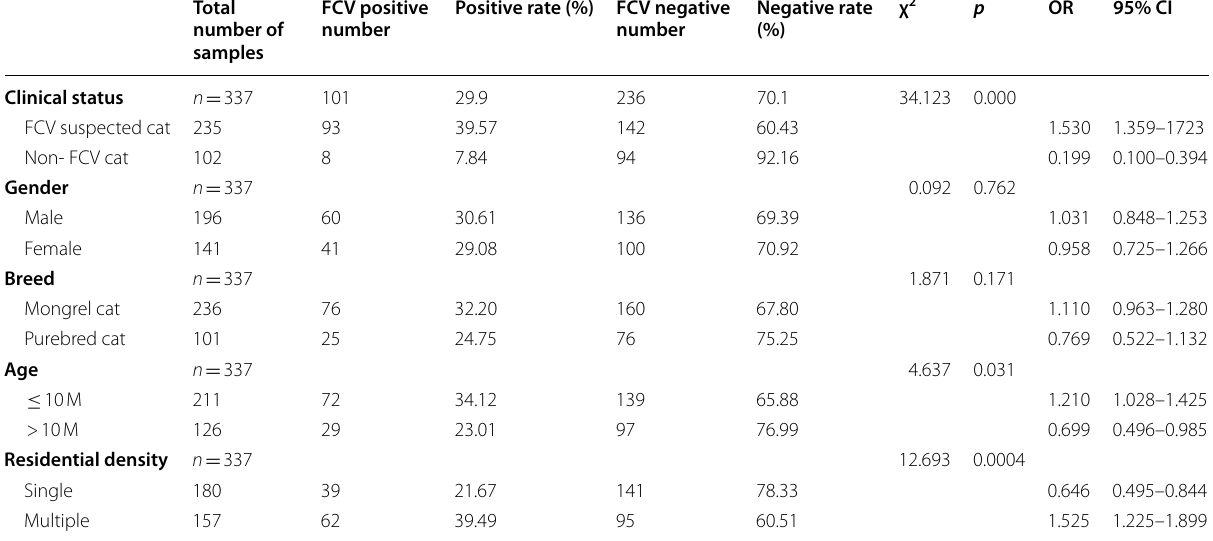
OR odds ratio, CI confidence